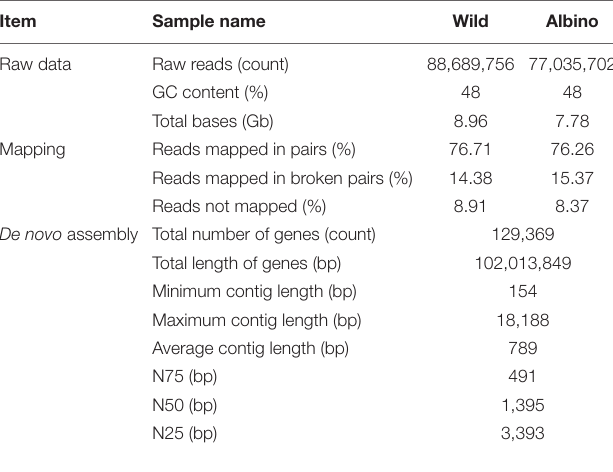
TABLE 2 | Summary of the sequencing data and transcriptome de novo assembled contigs and mapping